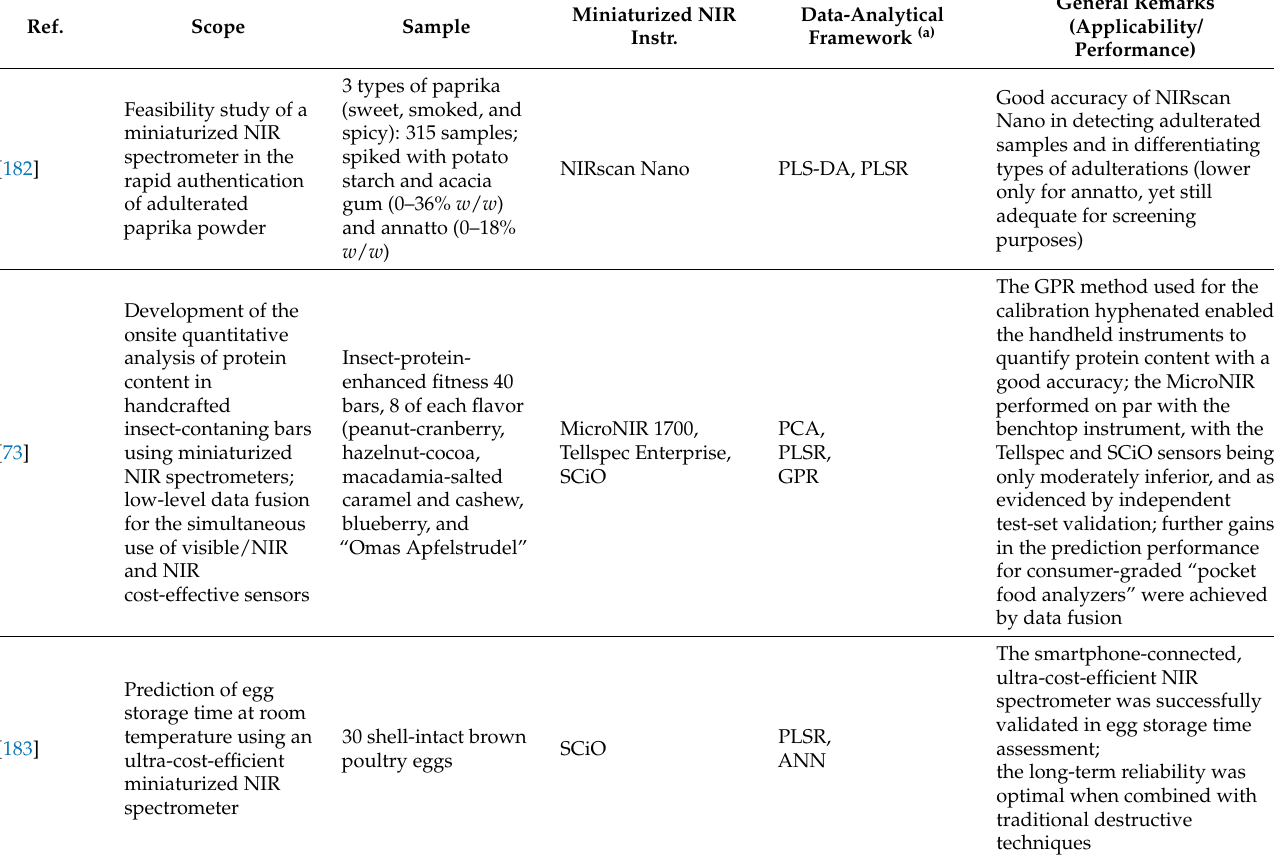
various miscellaneous